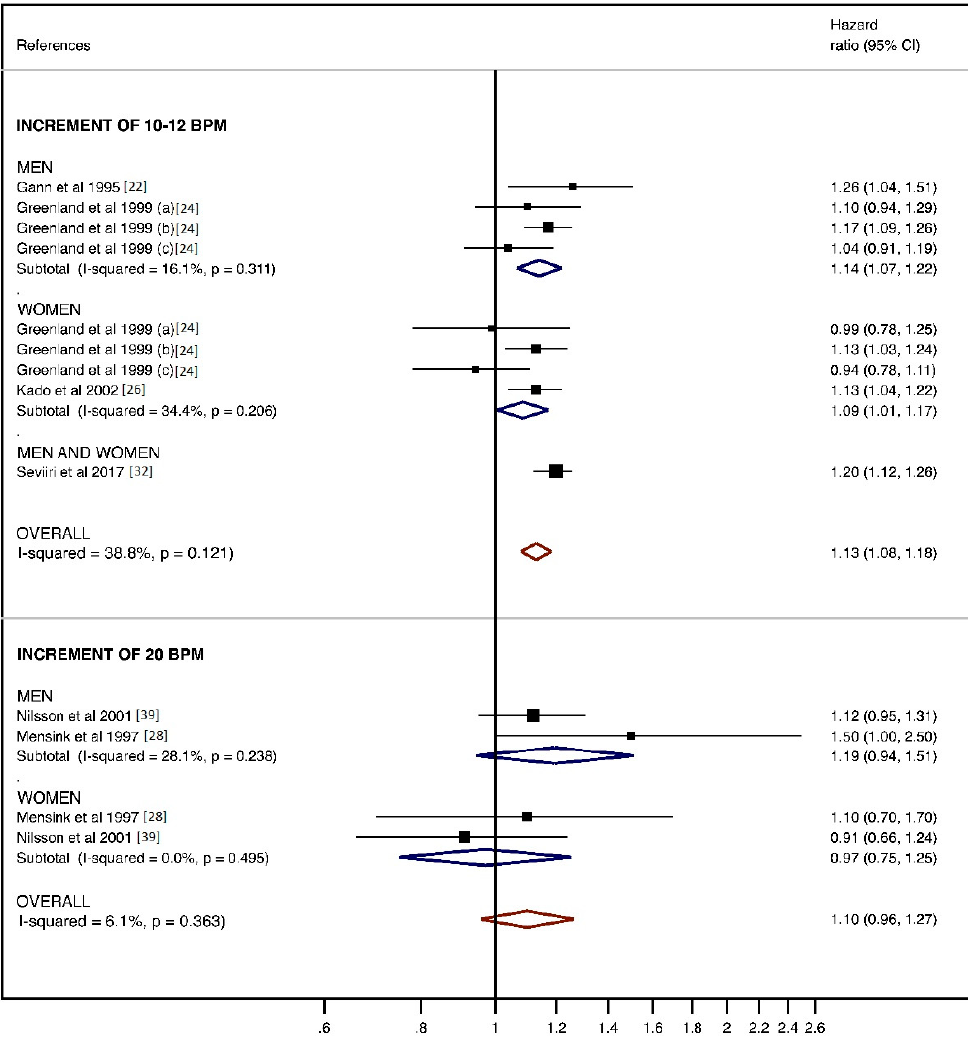
Figure 4. Analysis for 10–12 and 20 beats per minute (bpm) of resting heart rate (RHR) on risk of cancer mortality.